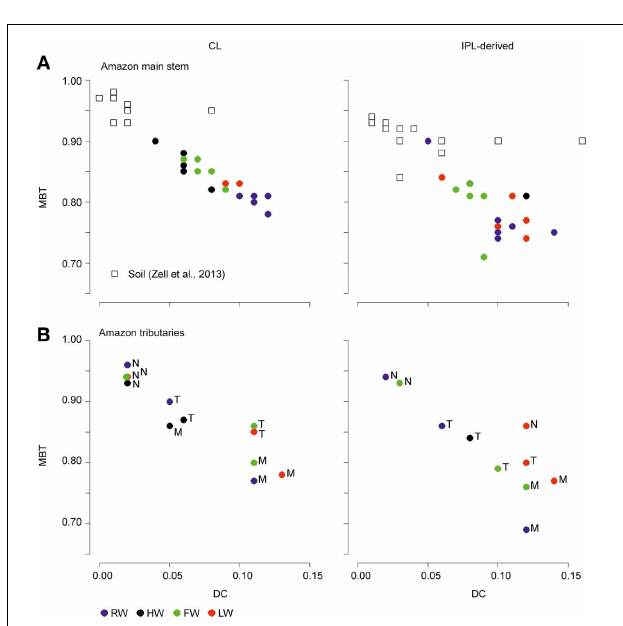
FIGURE 9 | Scatter plot of MBT vs. DC of CL and IPL-derived brGDGTs from the Amazon main stem SPM (Solimões and stations Amazon 1–4) (A) and Amazon tributaries (N, Negro; M, Madeira; T, Tapajós)